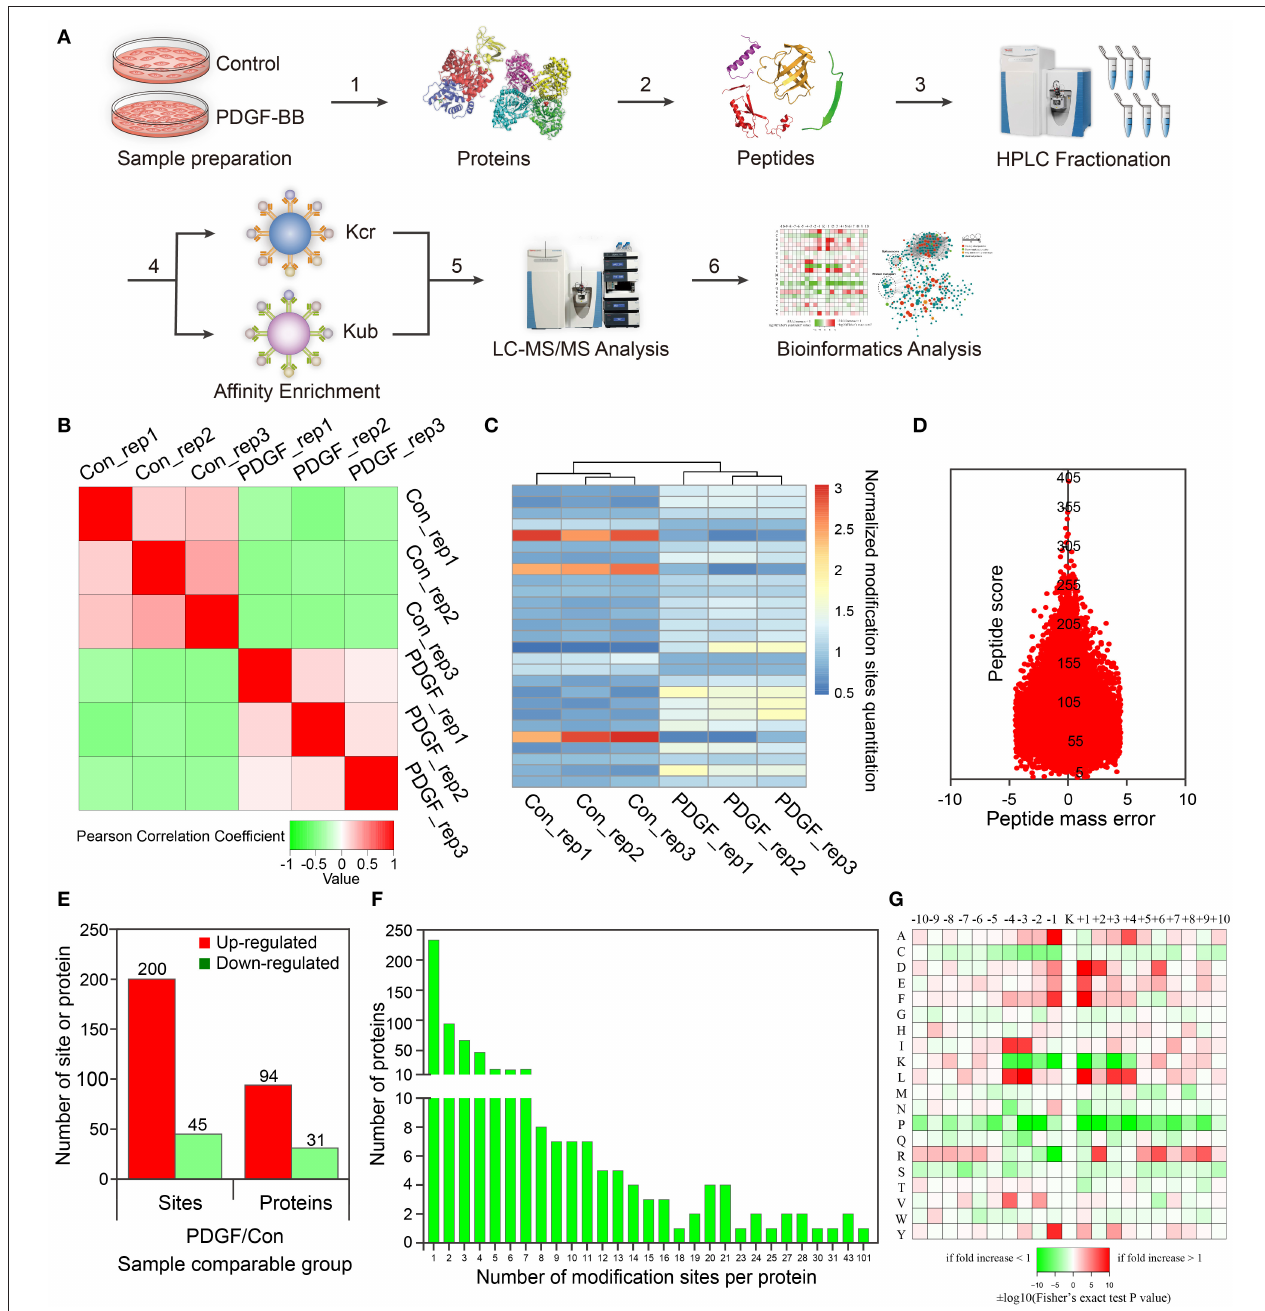
FIGURE 1 | Proteomic and crotonylomic profiling showed significant differences in vascular smooth muscle cells (VSMCs) upon platelet-derived growth factor-BB (PDGF-BB) treatment and control group. (A) A systematic workflow for quantitative profiling of global crotonylome. VSMCs pre- and post-treatment with PDGF-BB were extracted (step 1) and digested with trypsin enzyme (step 2). High-performance liquid chromatography (HPLC) was used to separate the peptides (step 3), and we then analyzed the peptides with mass spectrometry (MS) (step 5) after affinity enrichment using the pan anti-crotonyl-lysine monoclonal antibody and the pan anti-ubiquitinate-lysine monoclonal antibody (step 4). Finally, we use the data from MS for bioinformatics analysis (step 6). (B) A heat map was designed to calculate Pearson’s correlation coefficient using pairings of all samples. This coefficient is a value to measure the degree of linear correlation between the two sets of data: the closer Pearson coefficient is to − 1, the negative correlation is observed; the closer Pearson coefficient is to 1, the positive correlation is observed; the closer Pearson coefficient is to 0, the unrelated correlation is observed. Red shows a correlation coefficient of 1, green shows a correlation coefficient of − 1, and white shows a correlation coefficient of 0. (C) The heat map shows the quantitative differences in different modification sites between the two groups. (D) The mass error of the whole identified peptides. (E) Differentially expressed proteins and modification sites in the PDGF group relative to the Con group. (F) Statistical analysis of lysine crotonylation sites in all proteins. (G) Motif enrichment heat map of all the upstream and downstream amino acids of the identified crotonylation modification sites. Con represents the group of control without PDGF-BB treatment, and PDGF represents the group with PDGF-BB treatment. Rep represents repeat sample.